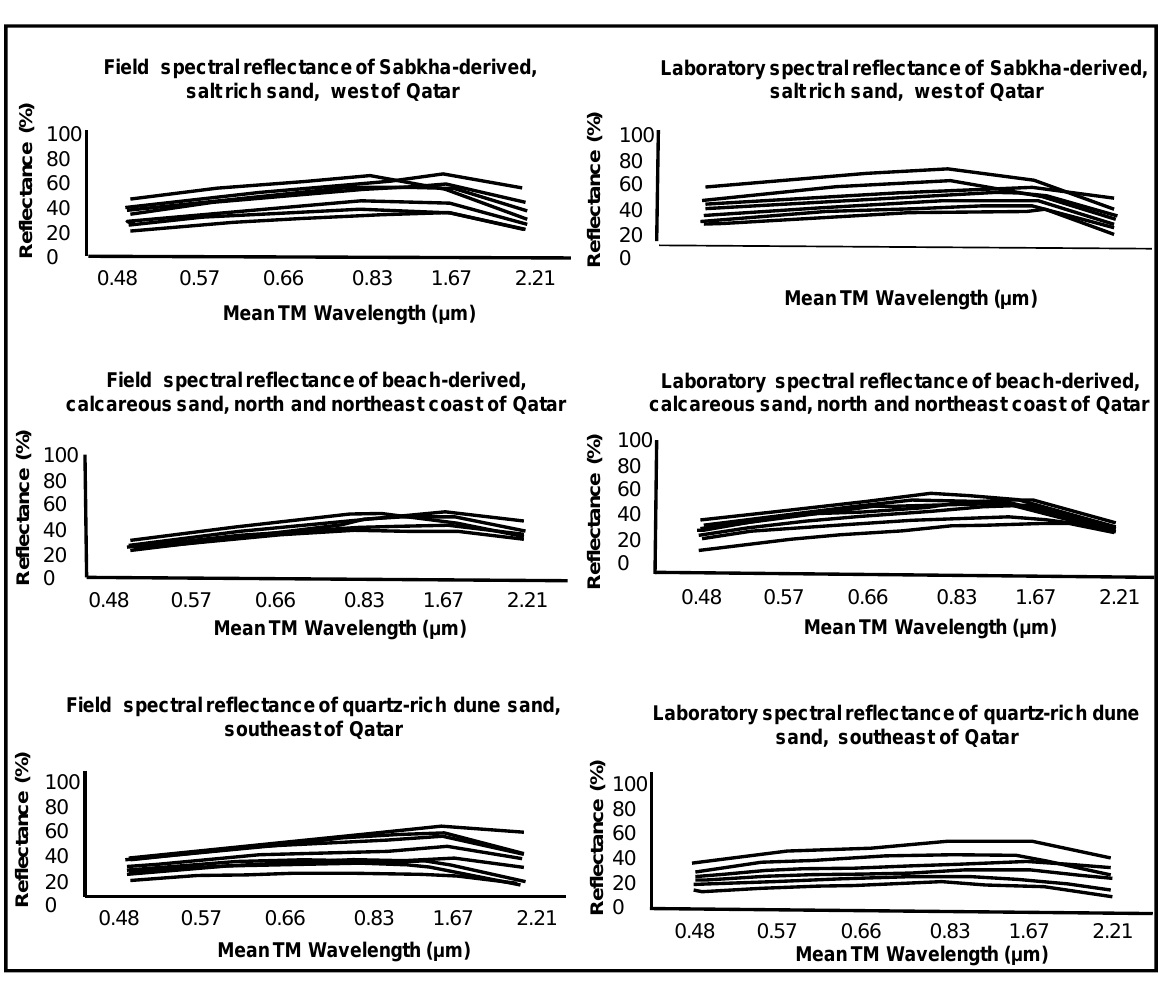
Figure 7. Field and laboratory spectral profiles of the main sand fields in